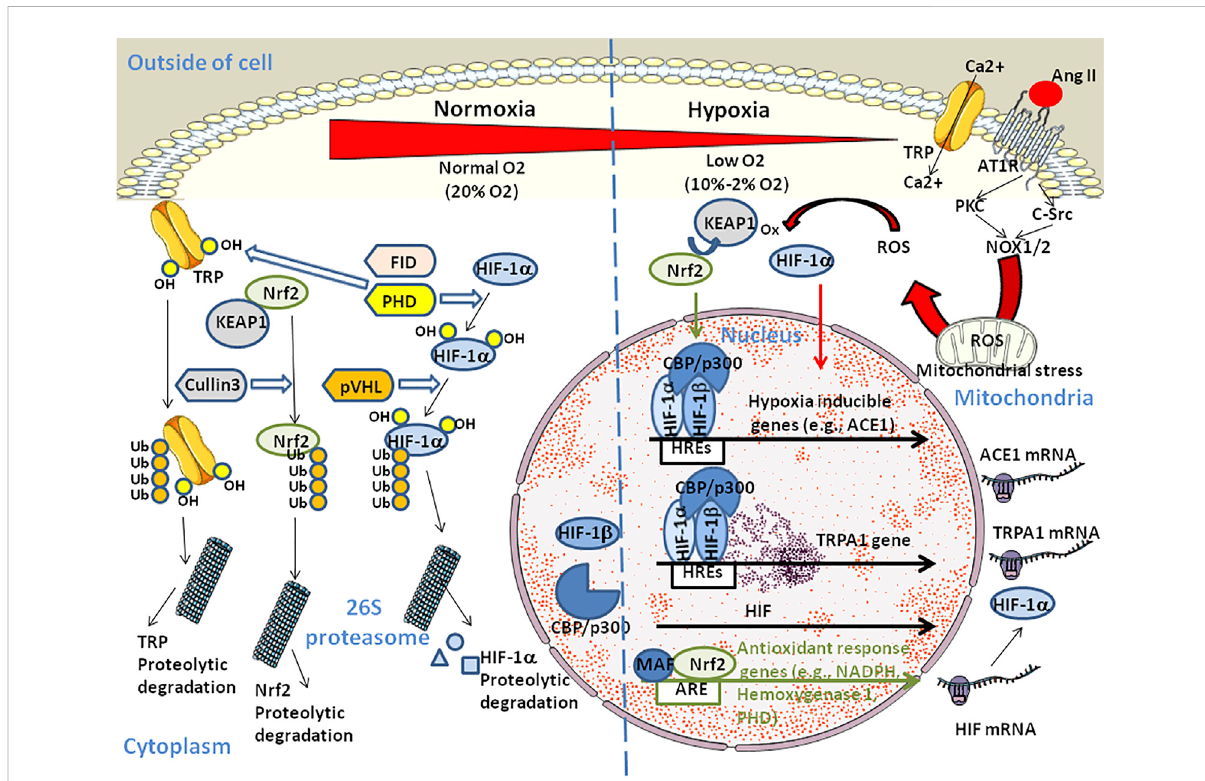
Schematic diagram illustrating the dual regulation of HIF. At high O2 concentration, HIF-1 α is hydroxylated on proline by the prolyl hydroxylase PHD. The ubiquitin ligase VHL targets HIV-1 α -OH for polyubiquitinylation and proteosomal degradation. Similarly, hydroxylation of TRP by PHD and asparaginyl hydroxylase FIH targets TRP-OH for ubiquitinylation and proteosomal degradation contributing to homeostasis. Under hypoxia, HIF-1 α translocates to the cell nucleus where it forms heterodimers with the HIF- β subunit and binds to the HRE element (the HRE core binding site sequence is 5 ’ -RCGTG-3 ’ with R being a purine) in the promoter of hypoxia-inducible genes and recruits histone acetyltransferases CREB Binding Protein (CBP)/p300. Hypoxia up-regulates ACE1 which contributes to Ang II production through the RAS pathway. Ang II can contribute to hypoxia through binding to AT1R which initiates signaling events including activation of PKC and c-Src that is required for superoxide production by NADPH oxidases (NOX1 and NOX2). NOX2 also stimulates the production of reactive oxygen species (ROS) by mitochondria. HIF-1 α nuclear translocation also activates the transient receptor potential ankyrin 1 (TRPA1) gene expression which leads to increase in intracellular Ca2+ and cell injury. In parallel (not shown), Ang II triggers an increase in cytoplasmic Ca2+ that induces NOX5 to generate H2O2. The Kelch-like erythroid cell-derived protein(KEAP1)isanegativeregulatorofthenuclearfactor(erythroid-derived2)-like2(Nrf2).Underhypoxia,KEAP1isoxidatedbyROS.Thisleadsto the nuclear translocation of phosphorylated Nrf2 which maintains oxidative homeostasis in regulating PHD thereby promoting HIF-1 α proteasomal degradation. The Nrf2/MAF (MAF BZIP transcription factor) heterodimers also induce transcription of anti-oxidant-response genes through binding to the antioxidant response element (ARE sequence: 5 ’ -TGACNNNGC-3 ’ ) and reduce both the concentration of ROS and pro-in fl ammatory cytokines.Inaddition,chronichypoxiatriggersHIF-dependentdownregulationoftheACE2geneandactivation ofADAM17whichleadstocleavage of the ACE2 protein (not